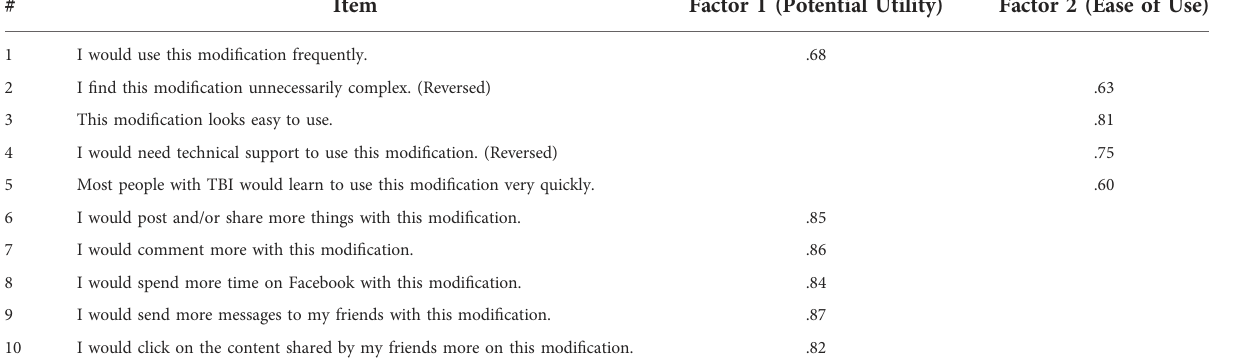
TABLE 7 Factor analysis of the ten item measures.